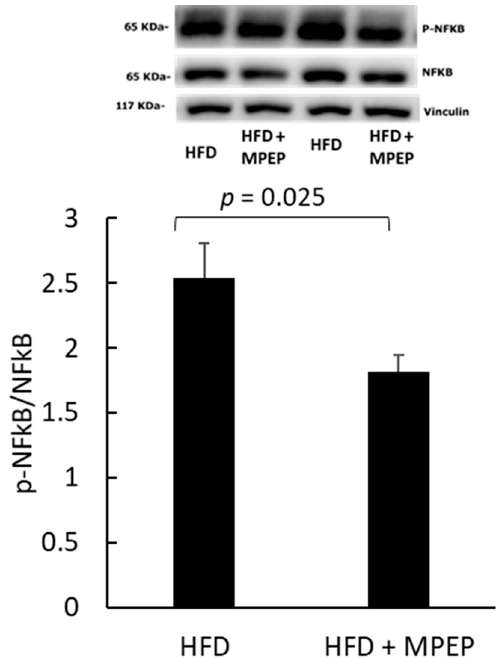
Figure 9. NF- κ B activation in obese mice. NF- κ B in liver homogenates from obese mice after 7 weeks of HFD administration, treated with MPEP 20 mg/Kg or vehicle. Results are mean ± SE of 6 individual determinations.